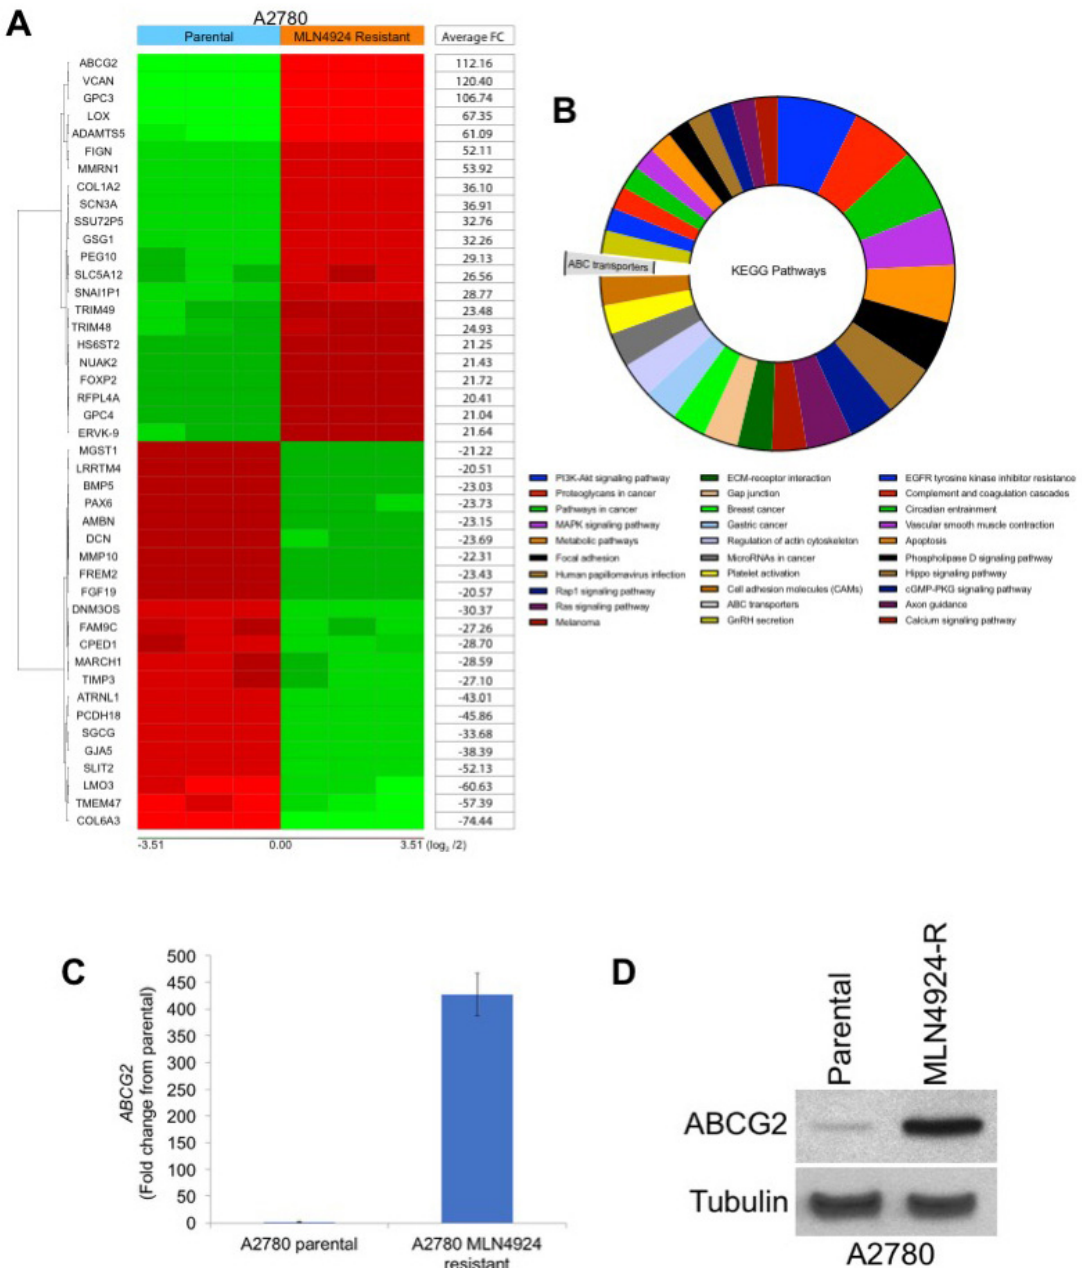
Figure 2. Gene expression analyses identify ABCG2 as a potential factor driving MLN4924 resistance. ( A ) Transcriptome analyses identify ABCG2 as one of the most upregulated genes in MLN4924-resistant cells. Gene expression changes in parental and resistant A2780 cells were determined using A ff ymetrix expression arrays. Genes with the most significant induction / repression are illustrated in the heat map. ( B ) Schematic of the significantly altered pathways in MLN4924-resistant cells. The top 30 pathways associated with significantly changed genes by 5-fold or greater (percentage of gene hit against the total number of genes) were analysed using KEGG pathway analysis. ( C ) Quantitative real-time PCR analysis of ABCG2 levels. ABCG2 expression in parental and resistant cells was measured by qRT-PCR. Mean ± SD, n = 3. ( D ) ABCG2 protein expression is dramatically upregulated in MLN4924-resistant cells. ABCG2 expression was determined in parental and resistant cells by immunoblotting.